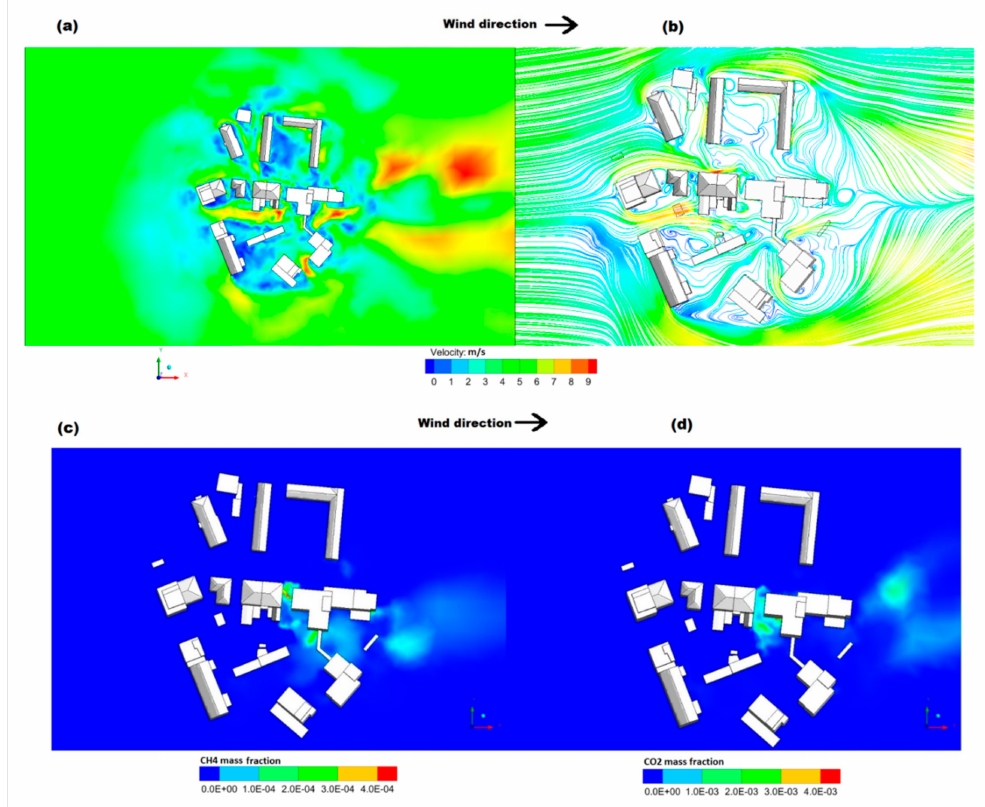
Figure 8. ( a ) Instantaneous velocity contour at z = 10 m, ( b ) streamline at z = 10 m, ( c ) methane (CH 4 ) concentration at the ground z = 0 m, ( d ) carbon dioxide (CO 2 ) concentration at the